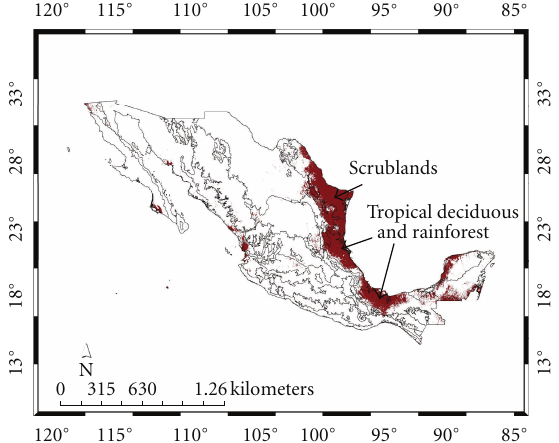
Figure 6: Species distribution model and ecoregions for Ambly- omma cajennense . The principal ecoregions are shown (see text).